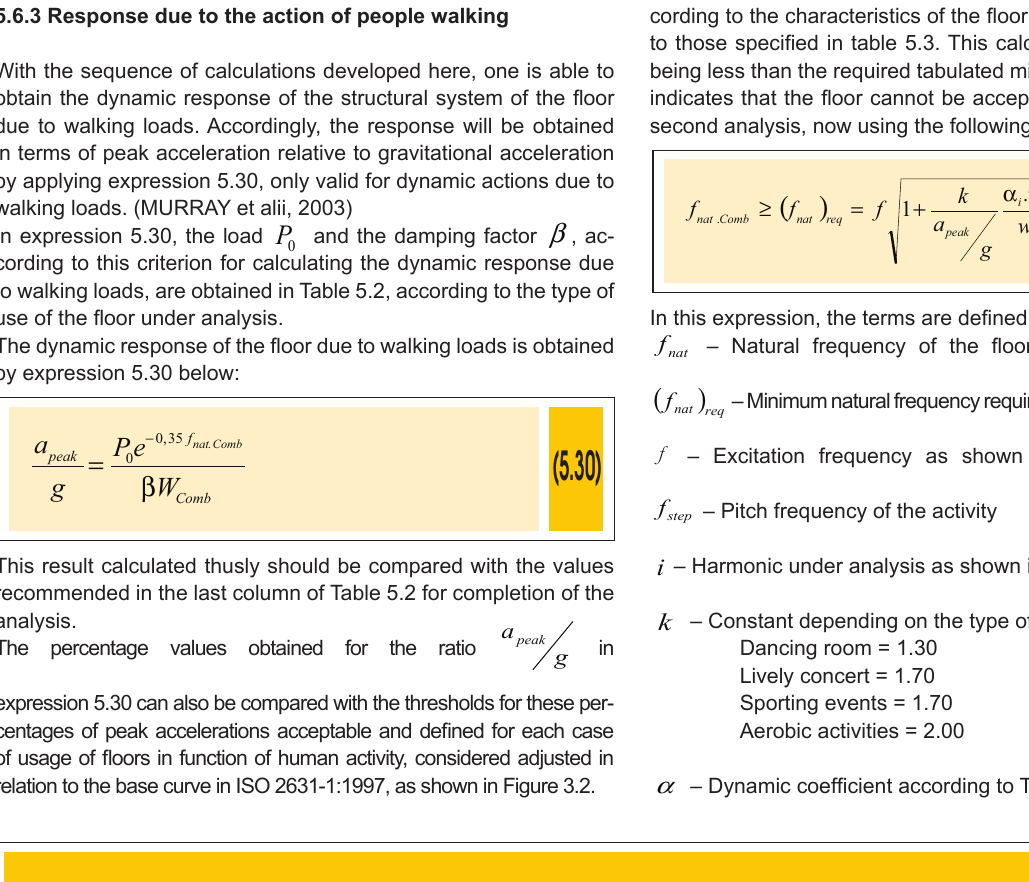
Table 5.2 – Recommended values for the parameters of equation 5.30 and limits (a /g) due to walking